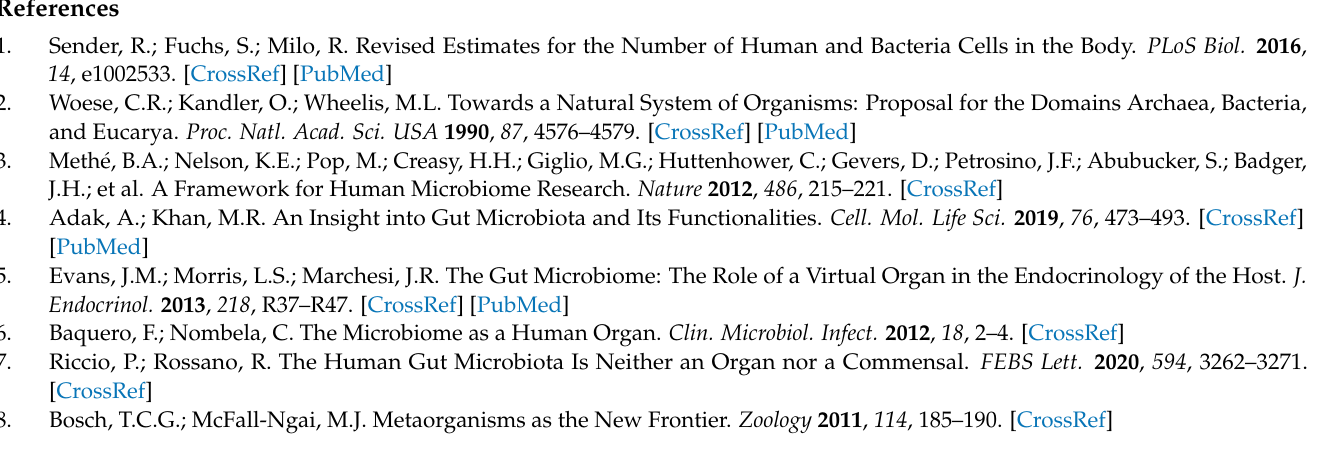
Table S2: Metagenetic analysis. References [151–157] are cited in the supplementary